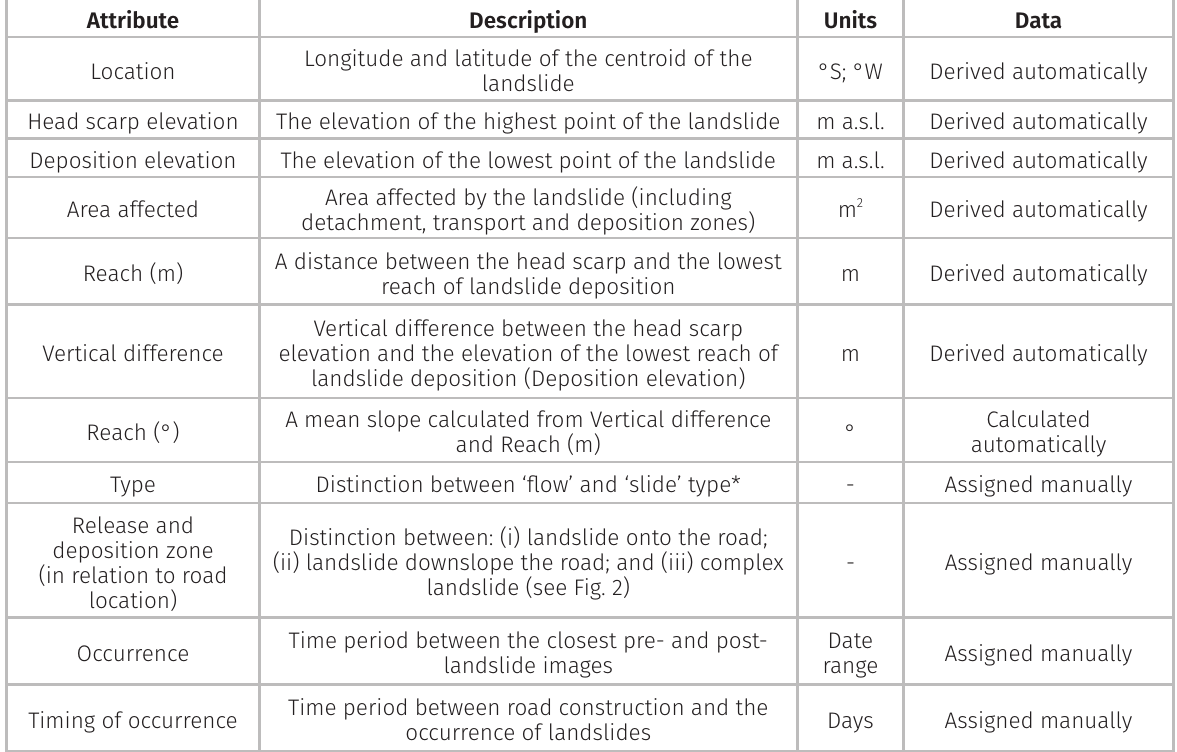
Table II. Attributes assigned to each of the manually identified landslides in the three areas of interest.